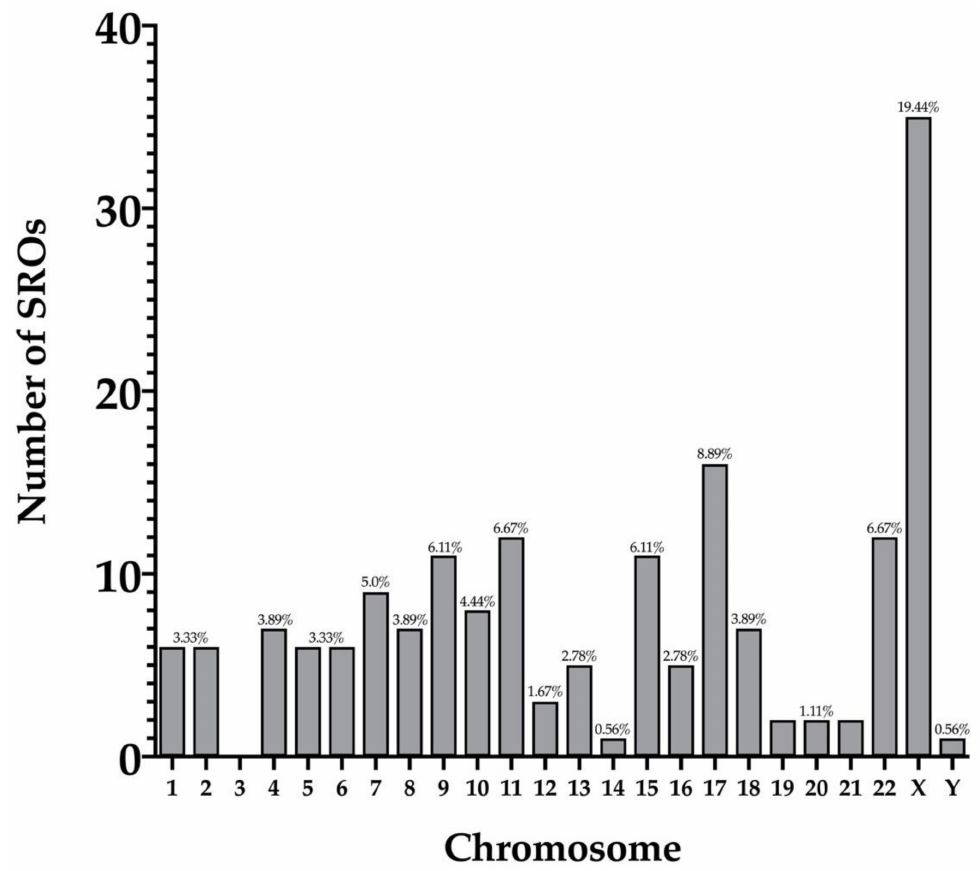
Figure 4. Number of SROs per